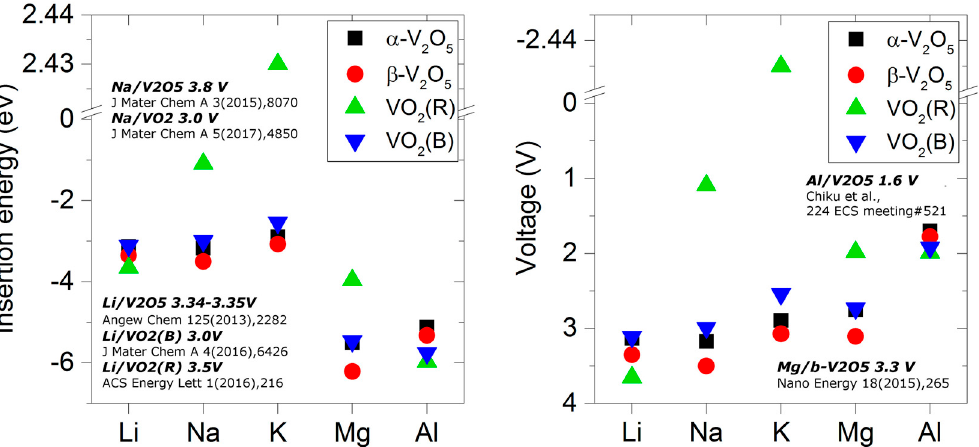
Figure 13. Insertion energies and corresponding voltages for single-atom Li, Na, K, Mg, and Al insertion in several phases of vanadium oxides. Where available, voltages following from experimental voltage-capacity curves are indicated in inserts.